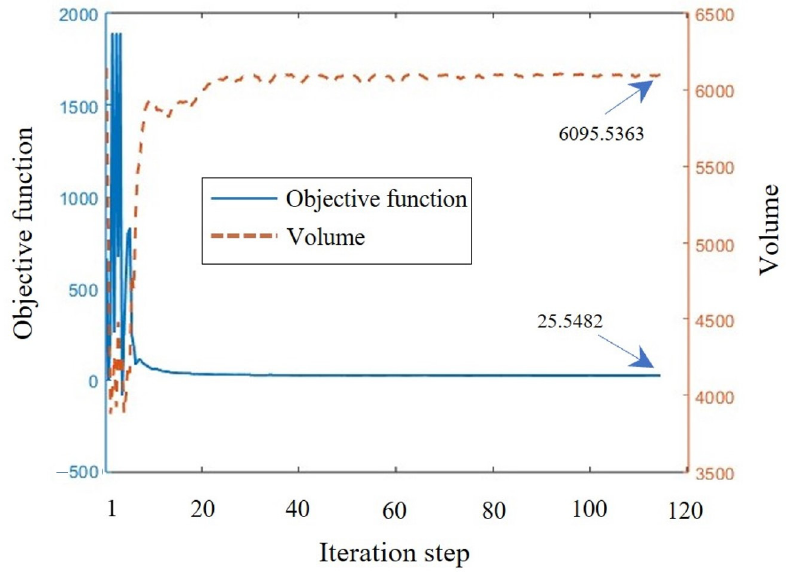
Figure 10. Convergence histories of the optimization using Equation (13). Table 1. Desired and undesired displacements of design results shown in Figures 7 and 8.